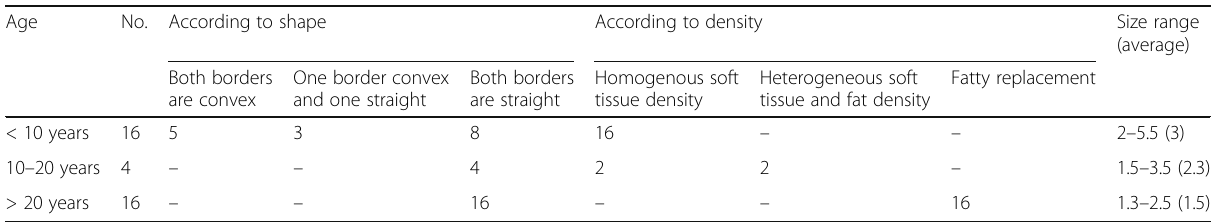
Table 1 Different sizes, shapes, and density of thymus gland in CT chest mediastinal window according to